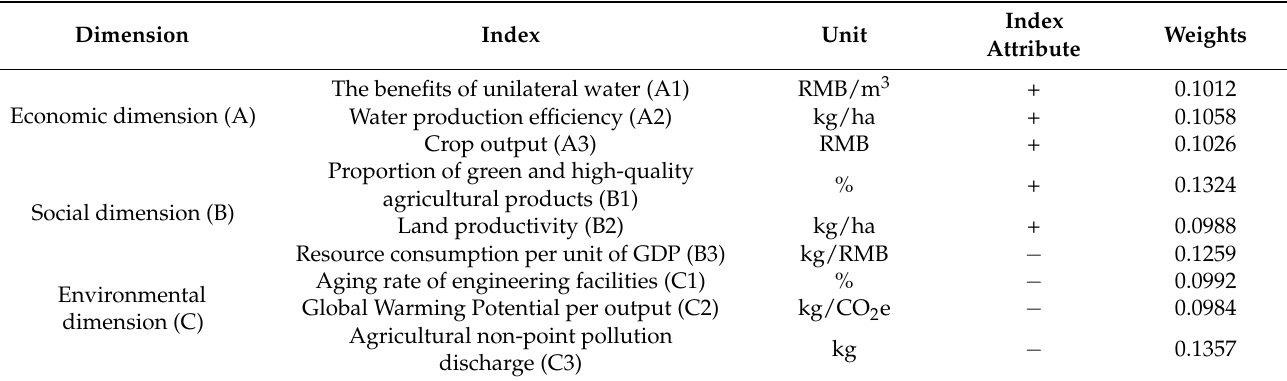
Table 1. Index system and weights.